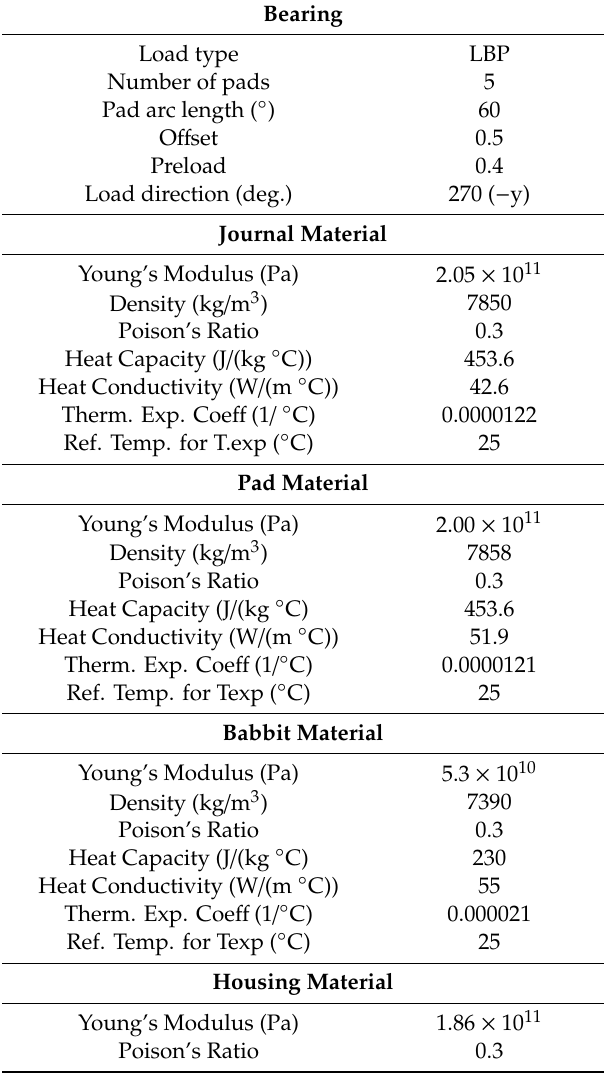
Table 2. Bearing system